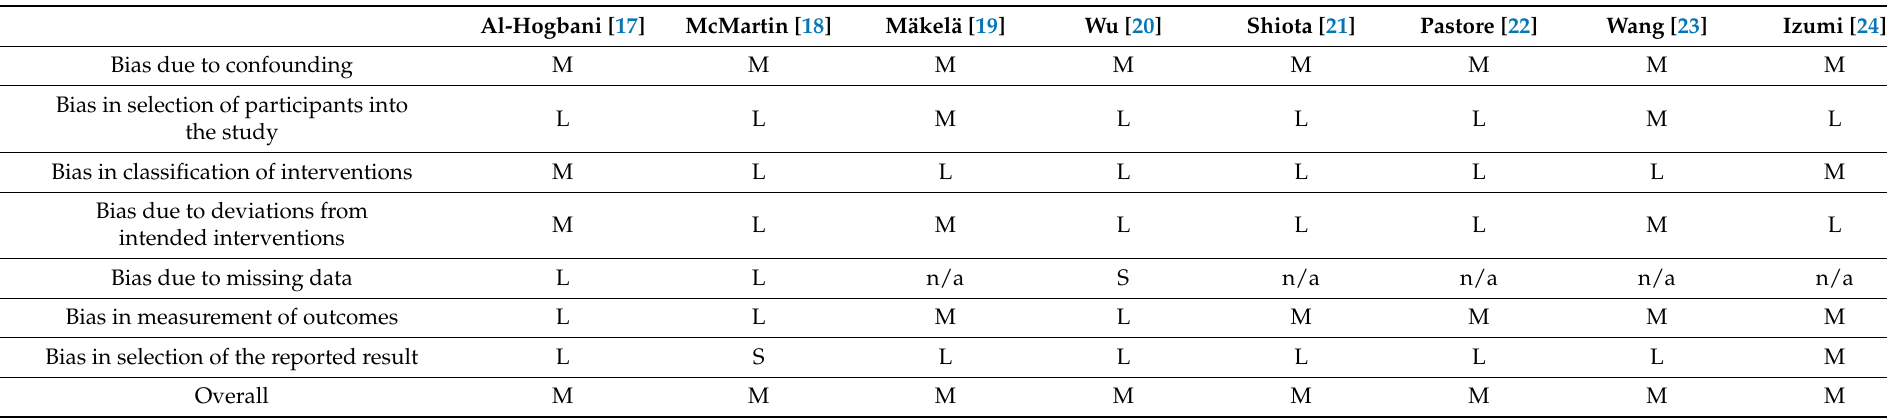
Table 3. Summary of risk of bias among included studies using Risk of Bias In Nonrandomized Studies - of Interventions (ROBINS-I)